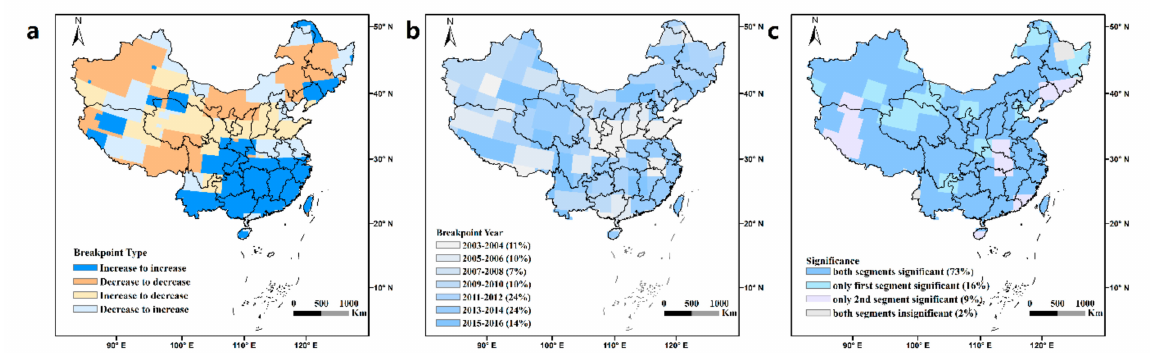
Figure 5. The breakpoint was detected in terrestrial water storage in monthly time series. Classified by